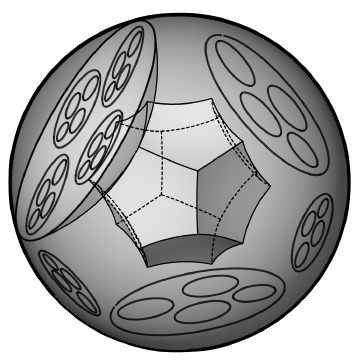
Figure 2: Example 6.8 on the boundary of a thin